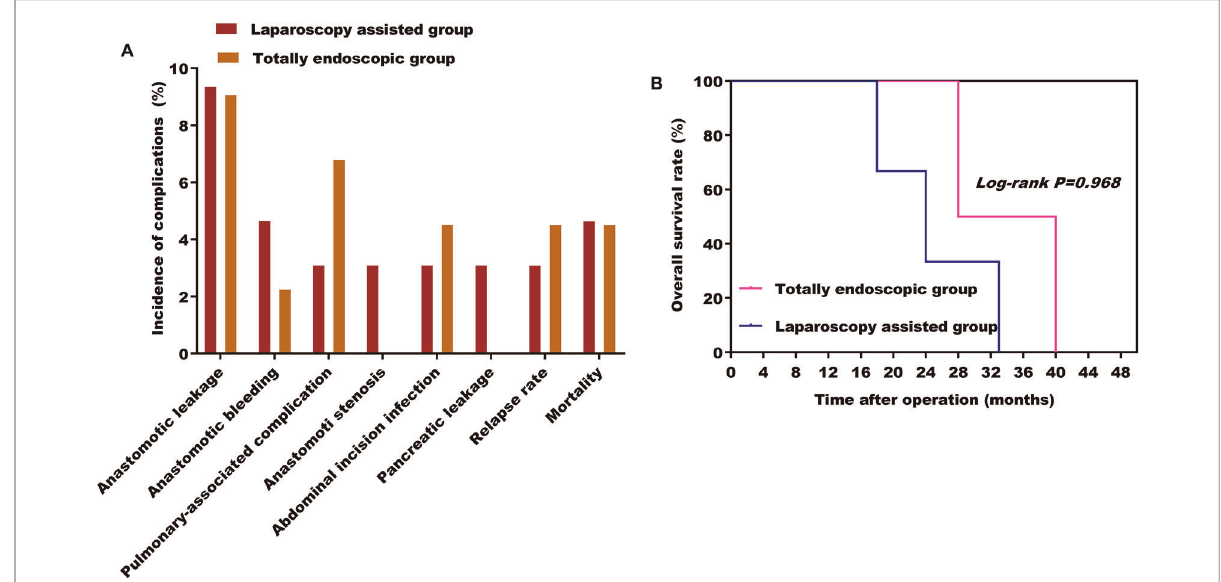
FIGURE 6 ( A ) Effect of different surgical methods on the incidence of postoperative complications; ( B) effect of different surgical methods on overall survival